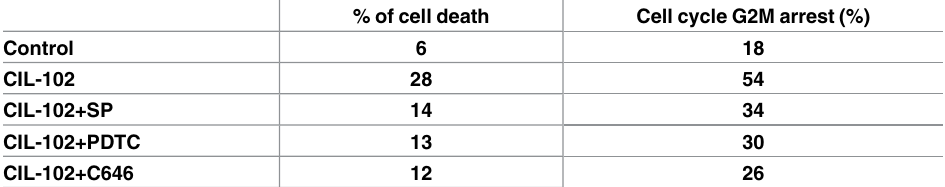
Table 1. Effects of the kinase inhibitor on the CIL-102 treatment associated with apoptosis and cell cycle distribution in DLD-1